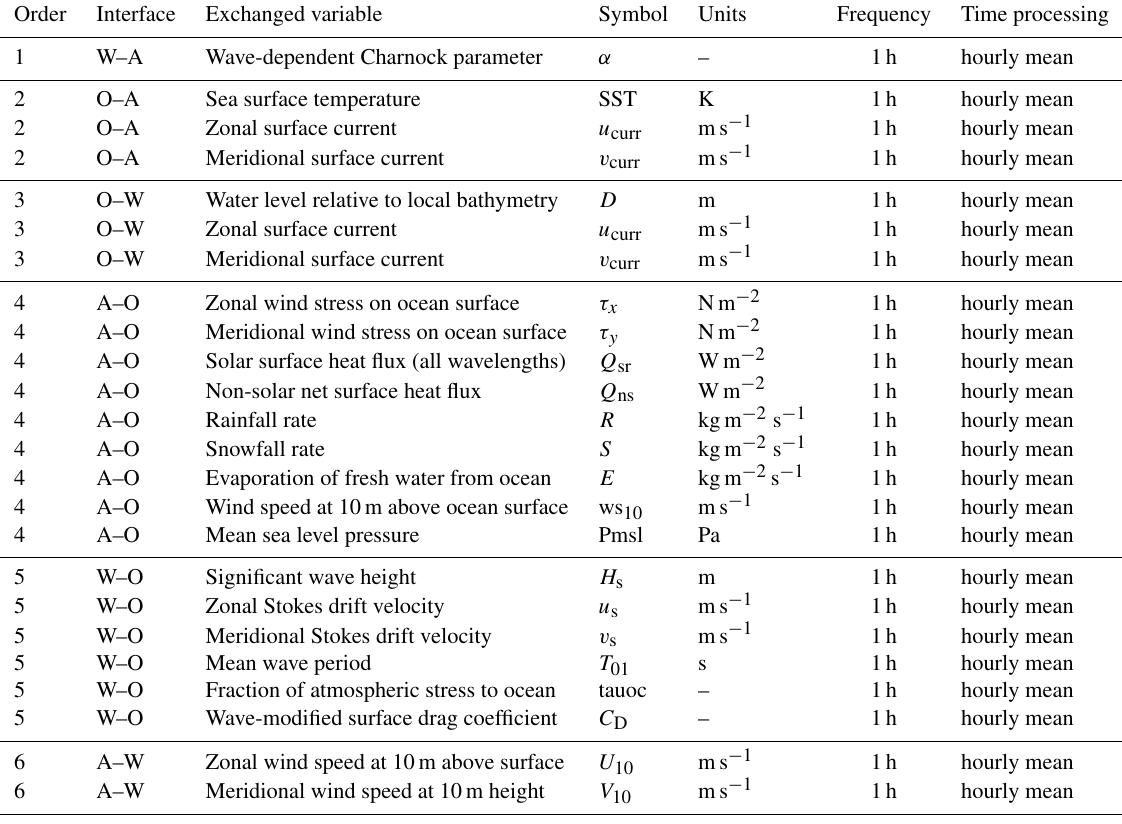
Table 3. Summary of coupling exchanges between atmosphere/land (A), ocean (O) and wave (W) components within the UKC3 regional coupled prediction system. Note that the W–O exchanges listed at order 5 are introduced for the first time in UKC3. Other variable coupling is as described by Lewis et al. (2018). Ensuring that exchanges occur between model components in the coupling order shown avoids system deadlocks within OASIS3-MCT. The coupling frequency highlights that all fields are currently exchanged every hour of the simulation time, and that all fields are computed as hourly mean values. See Sect. 2 for further